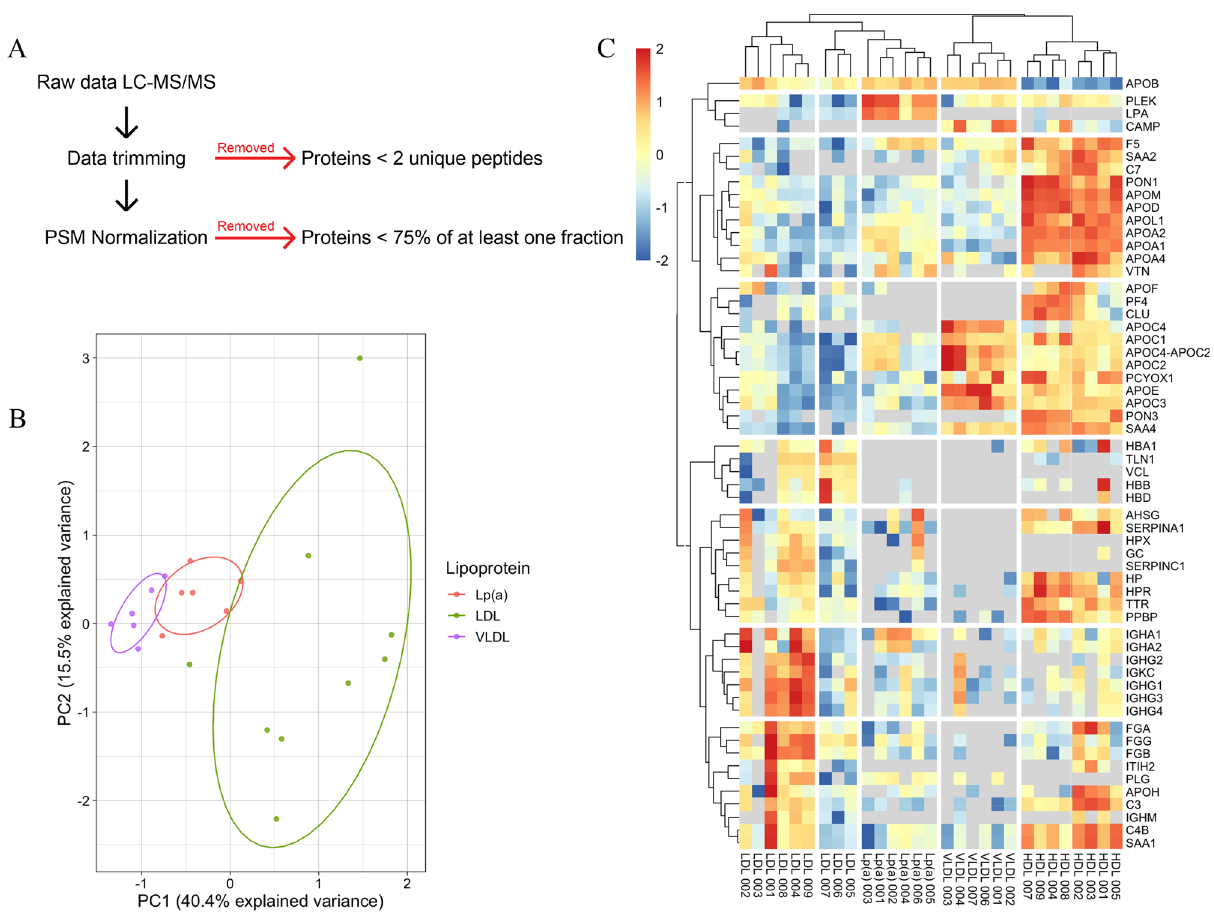
Figure 3. Proteomic characterization of isolated lipoprotein fractions from patients with elevated Lp(a). Lipoprotein fractions were isolated from whole plasma using a two-step density gradient ultracentrifugation and then dialyzed in potassium phosphate buffer. Isolated lipoprotein tryptic digests (1 µg) were separated by a 90-min linear gradient of solvents A (0.1% formic acid in water) and B (0.1% formic acid in acetonitrile) with a nanoACQUITY UPLC with an Acclaim PepMap nanoLC C18, 75 µm x 25 cm column. Data-dependent acquisition by Top 10 method was performed on a Q Exactive HF. ( A ) Raw data from liquid chromatography tandem mass spectrometry was subjected to trimming and analysis by first removing proteins with < 2 unique peptides. Spectral peptide peaks were aligned with Skyline software and peptide spectral matches (PSMs) were normalized to total PSMs prior to trimming. Finally, proteins found in < 75% of at least one lipoprotein fraction were excluded. ( B ) Principal components (PC) analysis was performed on each lipoprotein fraction (LDL in green, Lp(a) in red and VLDL in purple) using the trimmed data set and presented as a score plot for PC1 against PC2. ( C ) Normalized PSMs from each protein were transformed to a Z-score to demonstrate their relative abundance in each lipoprotein fraction. Lipoprotein fractions and proteins were grouped using Euclidean hierarchical cluster analysis and displayed in a heatmap (left